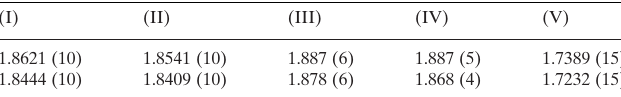
Table 3 M —F bond distances (A˚ ) for related cis/trans -[ M ( L ) 2 F 2 ] +